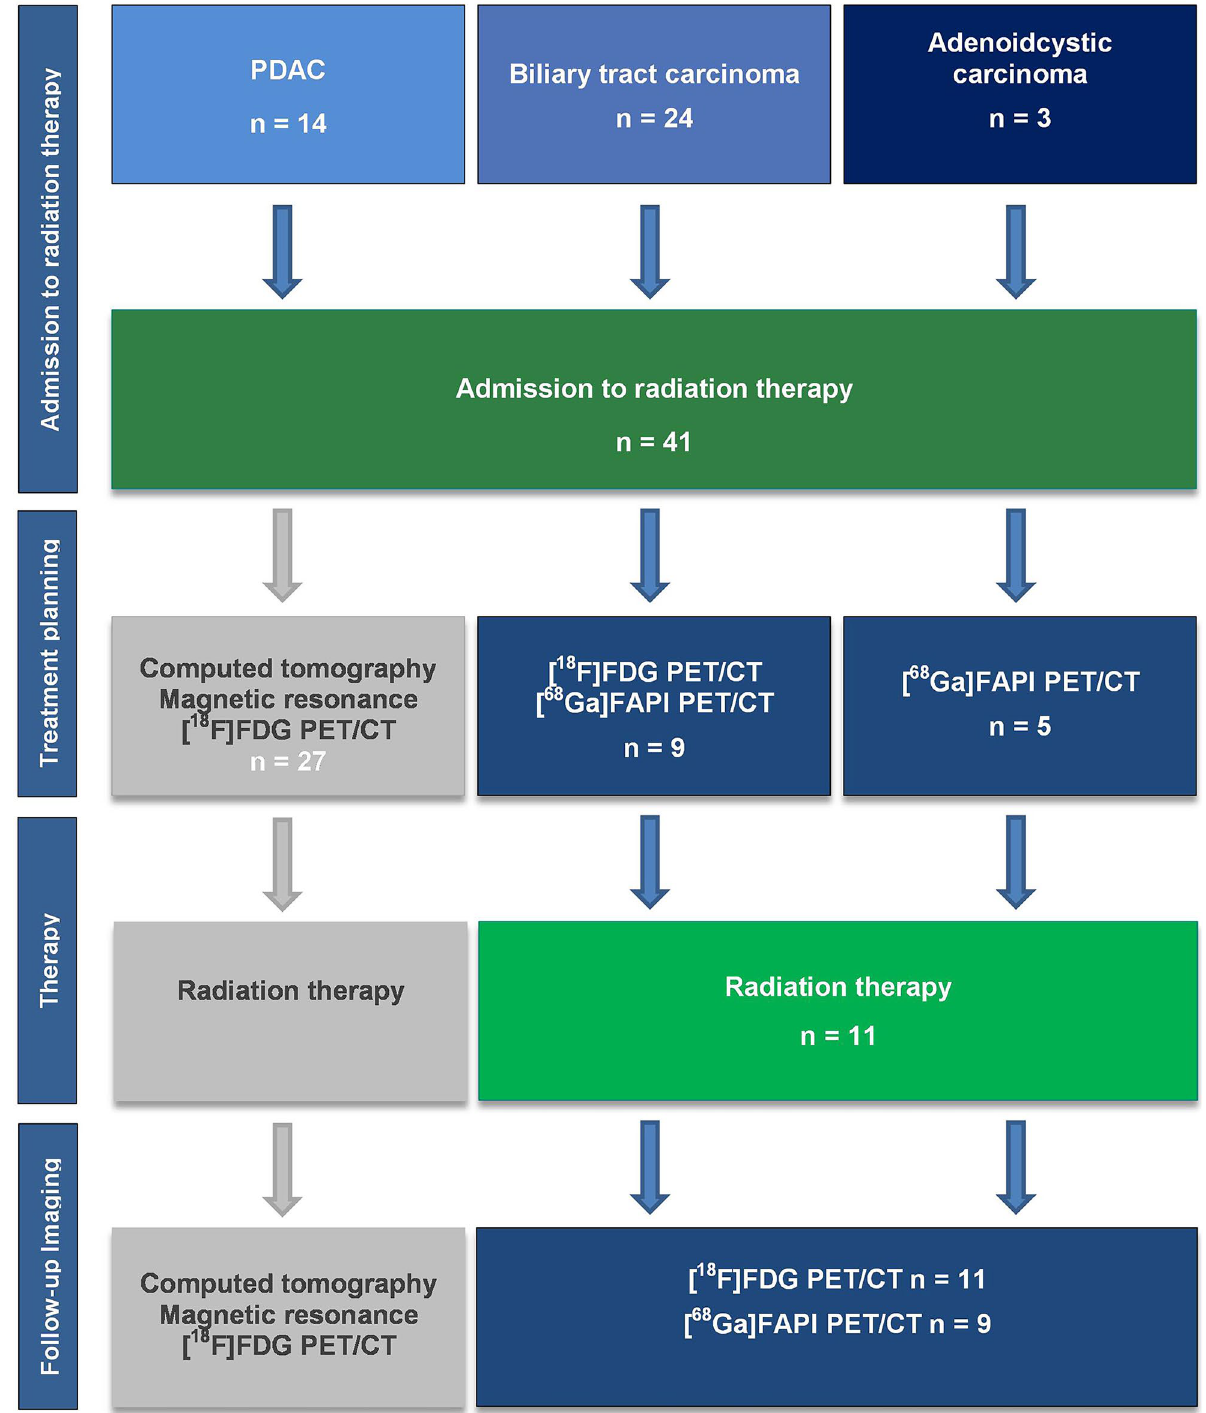
Figure 1. Consort diagram: all consecutive patients with pancreatic ductal adenocarcinoma (PDAC), biliary tract and adenoidcystic carcinoma were reviewed in the time period from 01.01.2020 to 01.03.2022. For study examination those patients who received a [ 68 Ga]FAPI-PET/CT prior to radiation therapy admission were